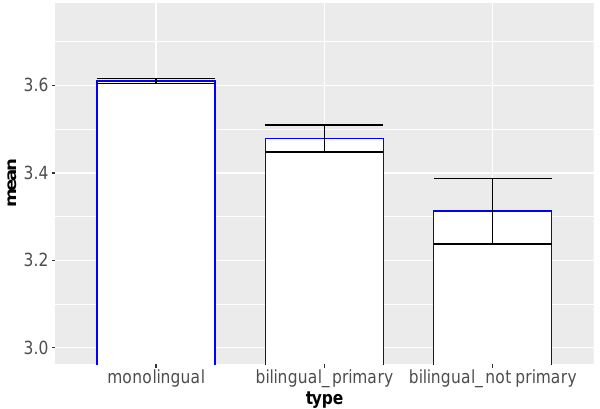
Figure 4. Re-analysis of Hartshorne et al. (2018), comparing simultaneous bilinguals whose primary language is or is not